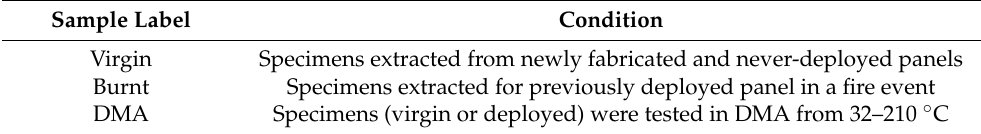
Table 1. Samples identification code and the corresponding testing and evaluation